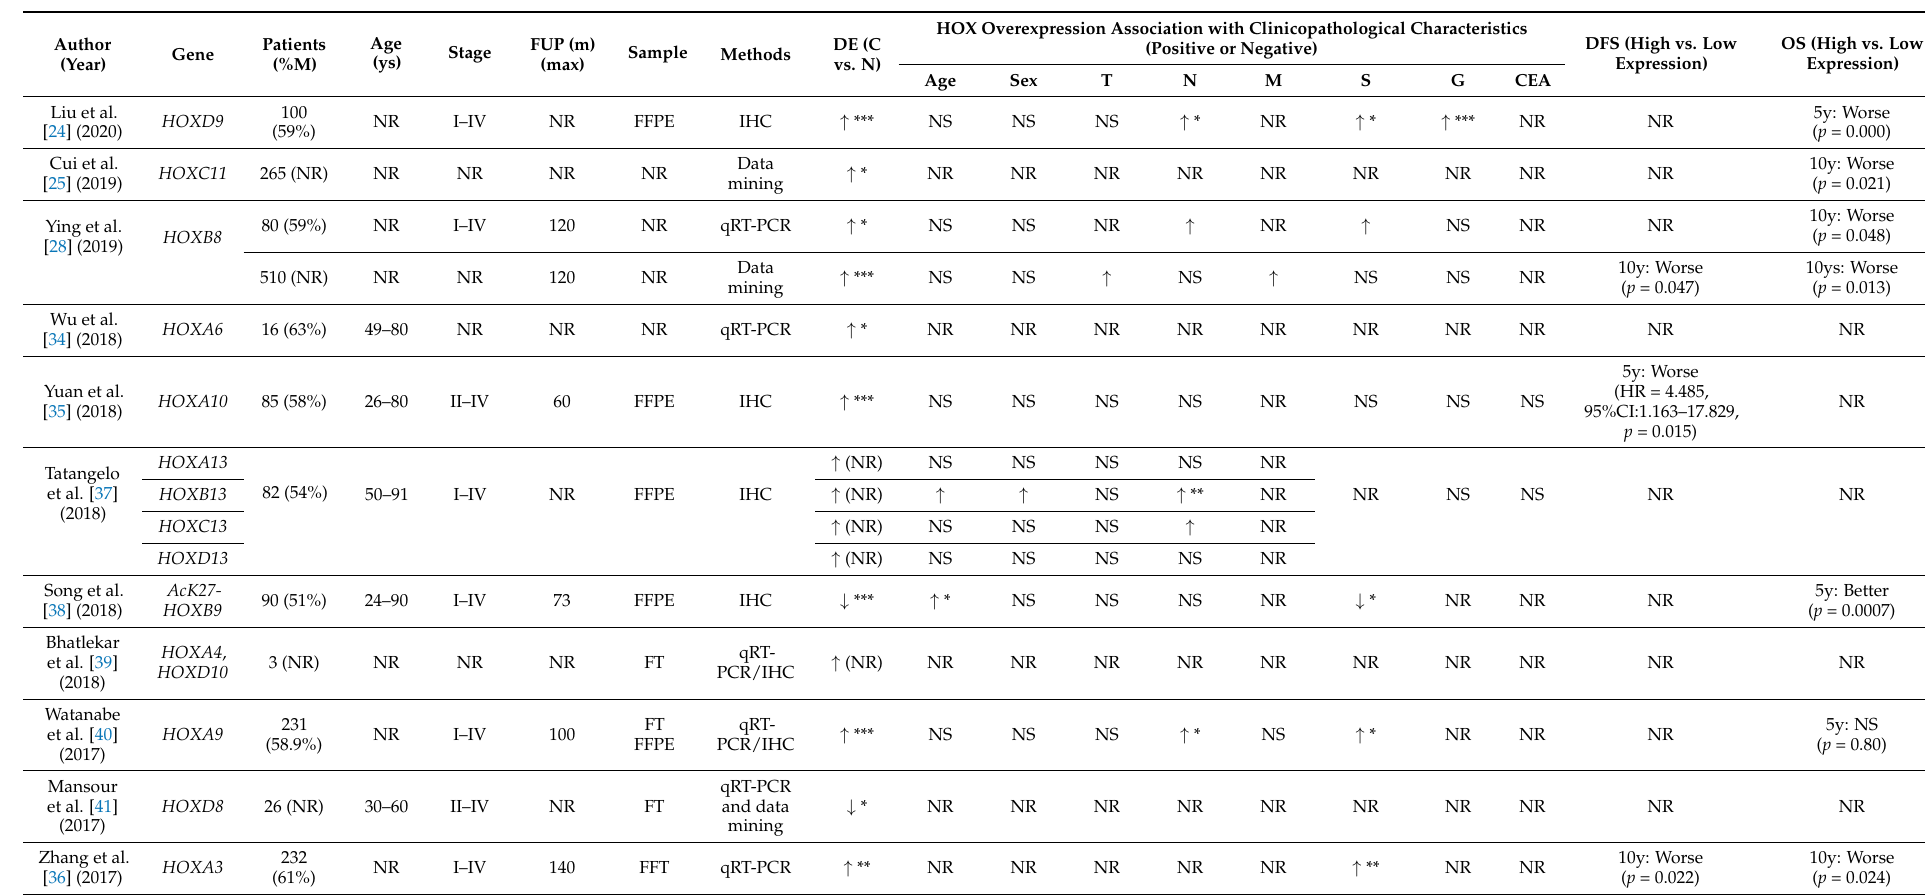
Table 1. Included studies reporting on clinicopathological and prognostic significance of HOX genes in CRC. *: p < 0.05, **: p < 0.01, ***: p < 0.001, ↑ : increased, ↓ : decreased. Arrows without a * or NR symbol represent findings that are characterized as borderline significant with a p -value ranging between 0.051 and